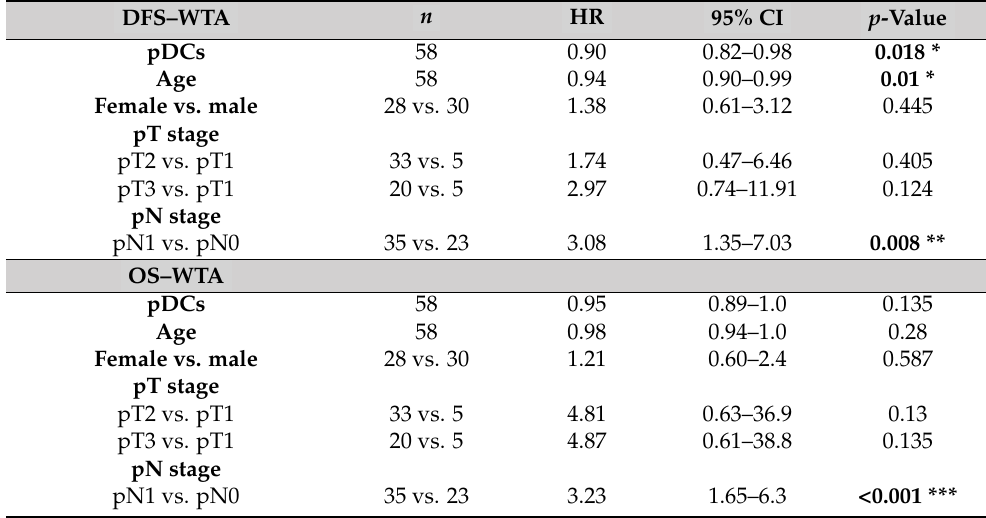
Table 4. Higher densities of whole tumor area (WTA)-infiltrating plasmacytoid dendritic cells (pDCs) influence disease-free survival (DFS) but not overall survival (OS). Hazard ratio (HR) and 95% confidence intervals (CI) are shown. p ≤ 0.05 was considered significant.